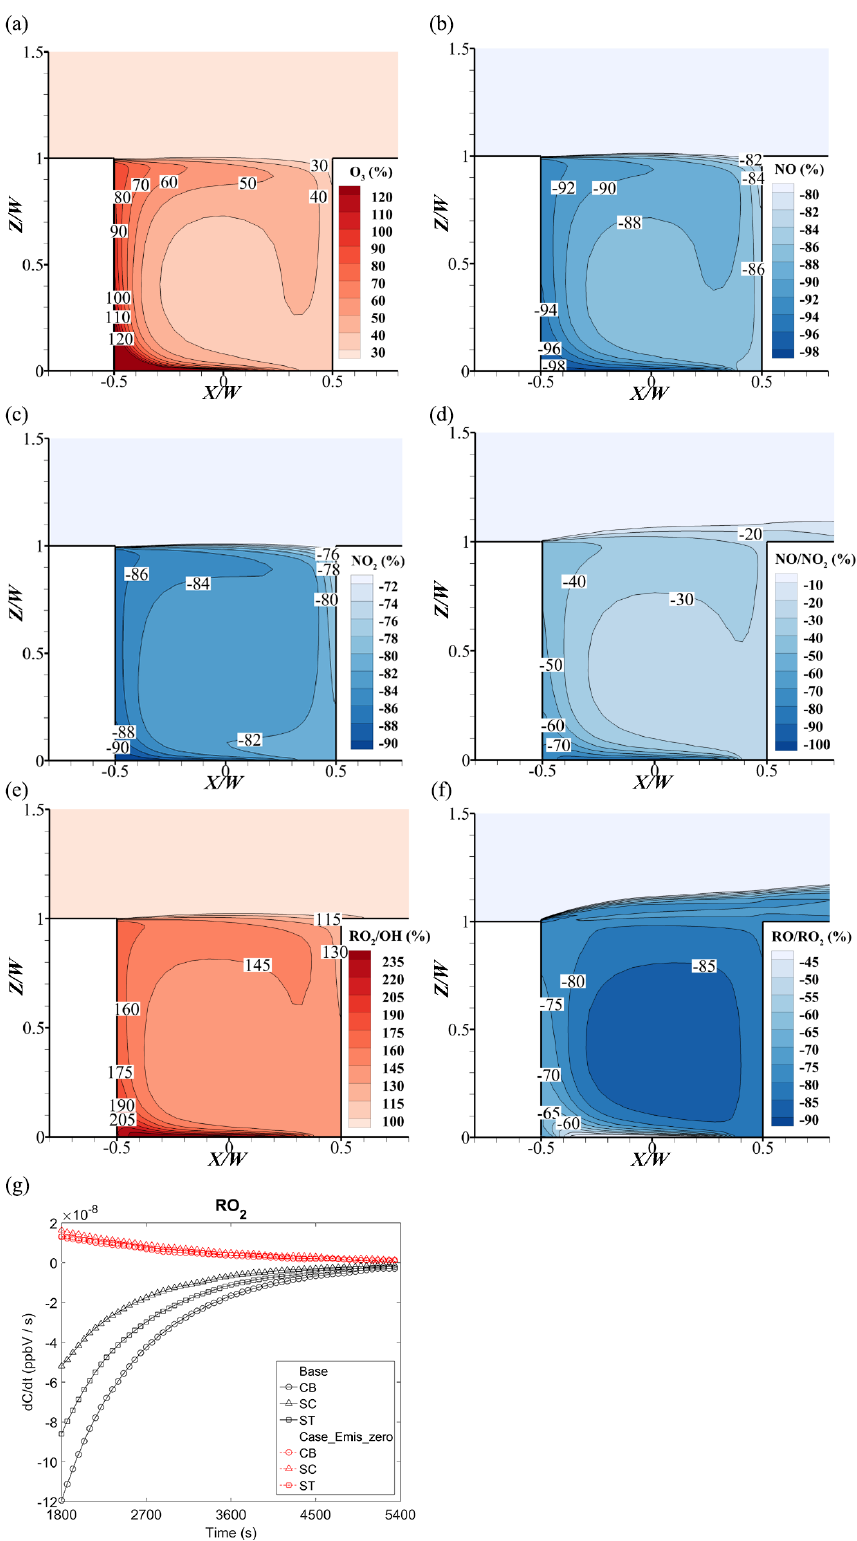
Figure 17. Change rate of (a) O 3 , (b) NO, (c) NO 2 , (d) NO / NO 2 , (e) RO 2 / OH, and (f) RO / RO 2 at t = 5400s. (g) Time series of the reaction rate of RO 2 ( dRO 2 ) of d t